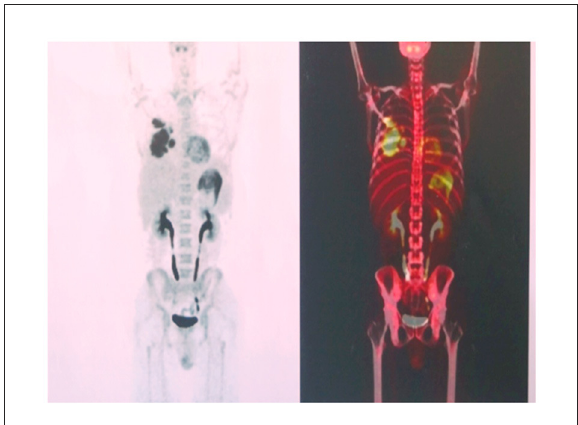
FIGURE2 High levels of 18F-fluorodeoxyglucose uptake on the right lung observed on positron emission tomography.